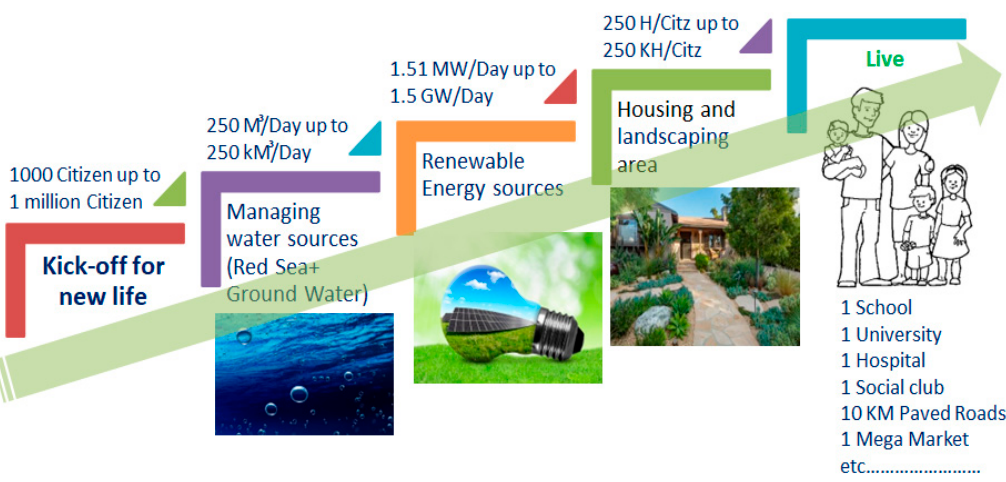
Figure 3. Conceptual design for Wadi-Dara valley per capita.